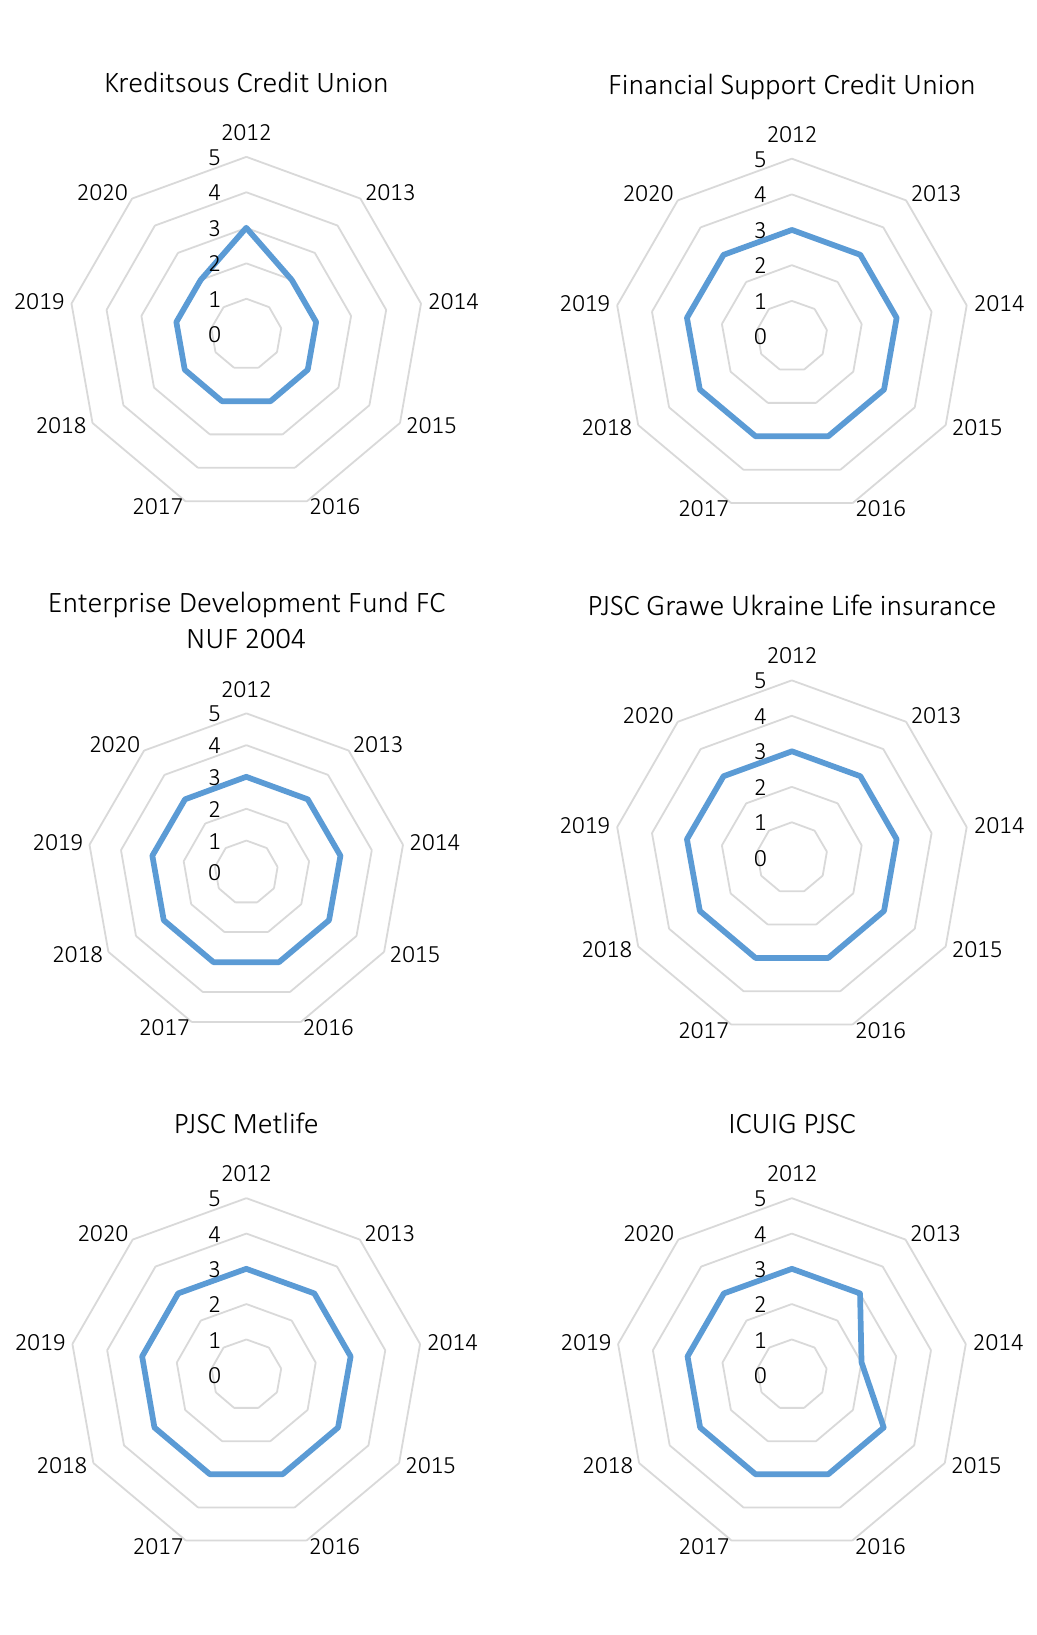
Figure A1 (cont.). Development patterns of financial intermediaries’